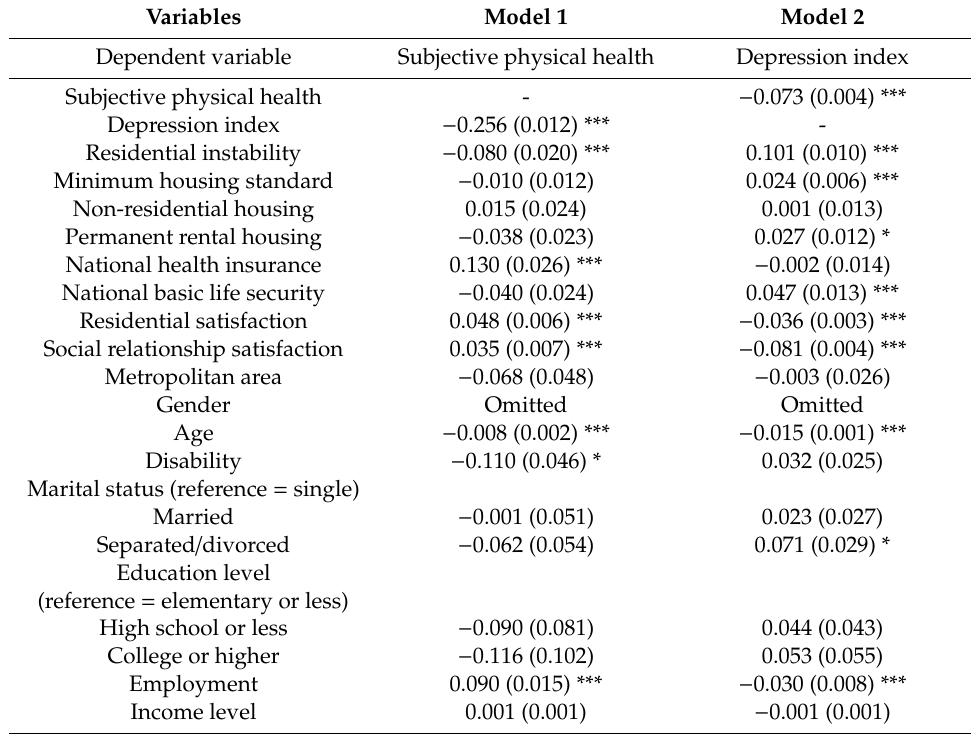
Table 4. Results of the fixed e ff ect panel